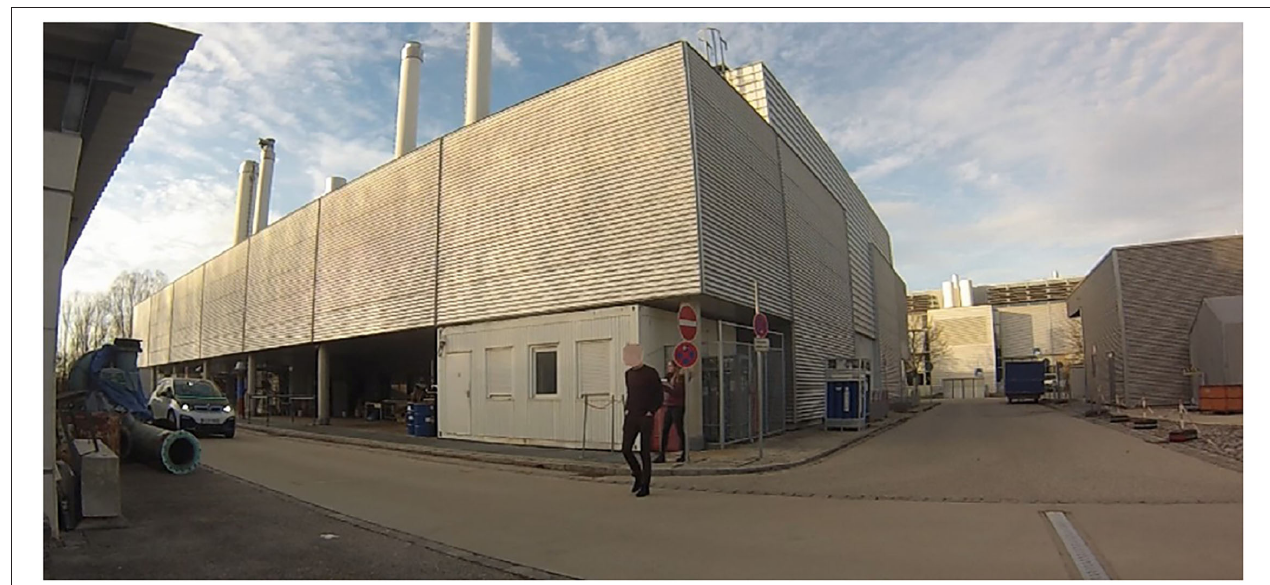
FIGURE 1 | The participants encountered the test vehicle with external human–machine interface (eHMI) at one of the two predefined interaction